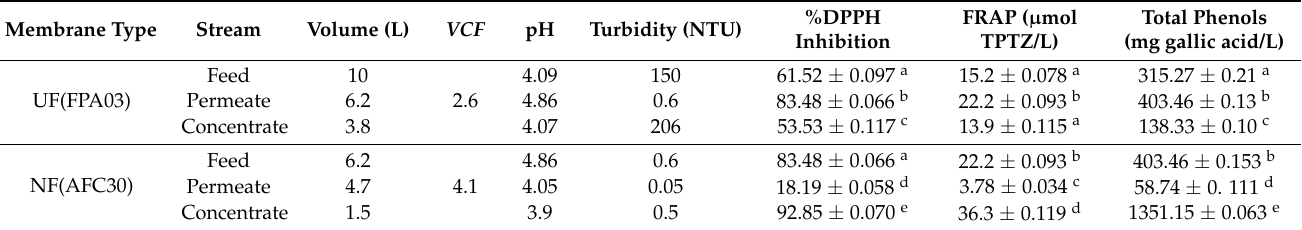
Table 3. Propertiesand phenoliccontent ofprocess streams and spray dried NFconcentrate (average ± SD, n = 3